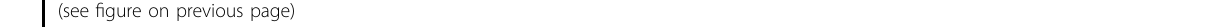
Fig. 3 The effects of Sgpl1 deletion on NPR2 activity and p21 expression in the ovary. The mRNA ( a ) and protein ( b , c ) levels of NPPC and NPR2 in ovaries of WT and KO mice. ( n = 3 independent experiments). GAPDH was used as a loading control. d Fluorescence images of calcium in granulosa cells after incubation with Fluo 3-AM (pseudocolor). f Statistical analysis of the calcium levels. The fl uorescence intensity indicates the mean ± SEM. ( n = 3 independent experiments. The total number of 21 follicles was scored in each group). e Fluorescence images of the binding af fi nity of NPR2 for NPPC in granulosa cells after incubation with FAM-NPPC (green). g Statistical analysis of the binding af fi nity. The fl uorescence intensity indicates the mean ± SEM. ( n = 3 independent experiments. The total number of 21 follicles was scored in each group). h Cyclic GMP levels in ovaries of WT and KO mice ( n = 3 independent experiments. The total number of 12 ovaries was used in each group). The mRNA ( i ) and protein levels ( j , k ) of p21 and PCNA in ovaries of WT and KO mice ( n = 3 independent experiments). β -actin was used as a loading control. Immuno fl uorescence analysis of PCNA ( l ) and BrdU ( m ) in ovaries of WT and KO mice (green). ( n = 3 independent experiments). Arrows show the positive granulosa cells. The nuclei were counterstained by DAPI (blue). Quantitative analysis of granulosa cells positive for PCNA ( n ) and BrdU ( o ) in WT and KO mice. The percentage of positive granulosa cells in secondary follicles was counted. ( n = 3 independent experiments. The total number of 36 secondary follicles was scored in each group). Scale bars: 100 μ m. Bars indicate the mean ± SEM. ns no signi fi cance, * p < 0.05, ** p < 0.01 and *** p < 0.001 vs. the WT